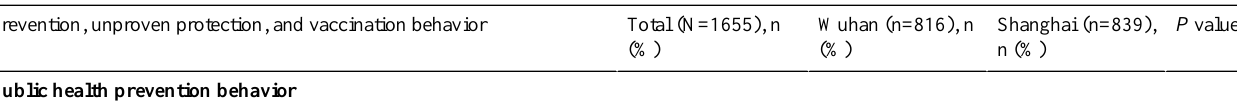
Table 2. Prevention, unproven protection, and vaccination behaviors among children and adolescents in Wuhan and Shanghai during the COVID-19